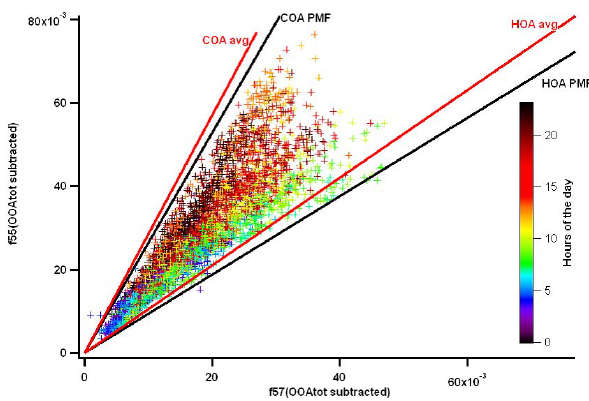
Fig. 9. Mass fraction of m/z 55 and 57 ( f 55 and f 57 ) for primary organics at the LHVP site. Reference lines for pure COA and HOA (defined as COA avg and HOA avg , respectively) are